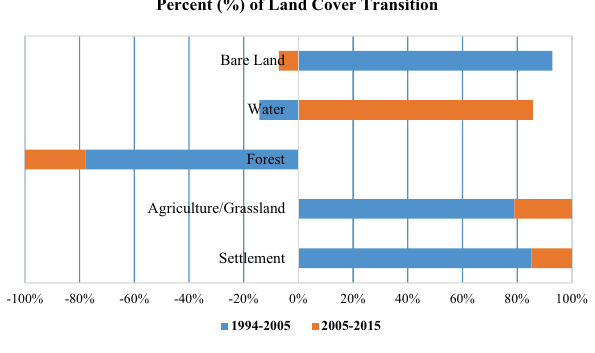
Fig. 3 Transition of land cover types